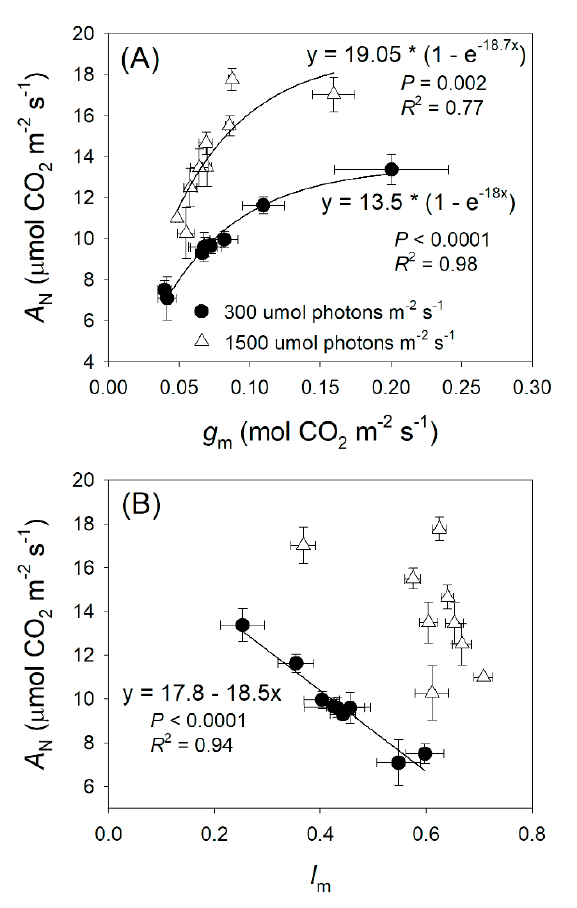
Figure 4. The relationship between g m and A N ( A ), l m and A N ( B ) at 300 and 1500 μ mol photons m − 2 s − 1 in nine Rhododendron species. Symbols represent means ± SE ( n =